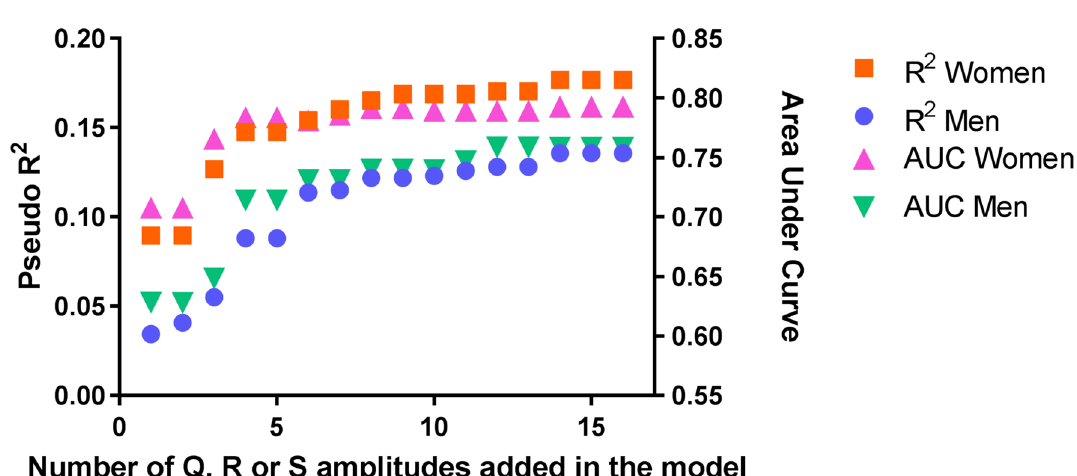
Figure 2. Heatmap of the correlation of Q, R and S waves with LVMi in the training cohort. Correlations are displayed separately for men and women and the difference between men and women. The darker the color in the heatmap, the stronger the correlation of Q, R and S waves with LVMi. Correlation coefficients between − 0.05 (yellow in women, light purple in men) and 0.30 (brown in women, dark blue in men) were observed in women and men. In both men and women, R and S waves are more often highly correlated to LVMi than Q waves. QRSd QRS duration.